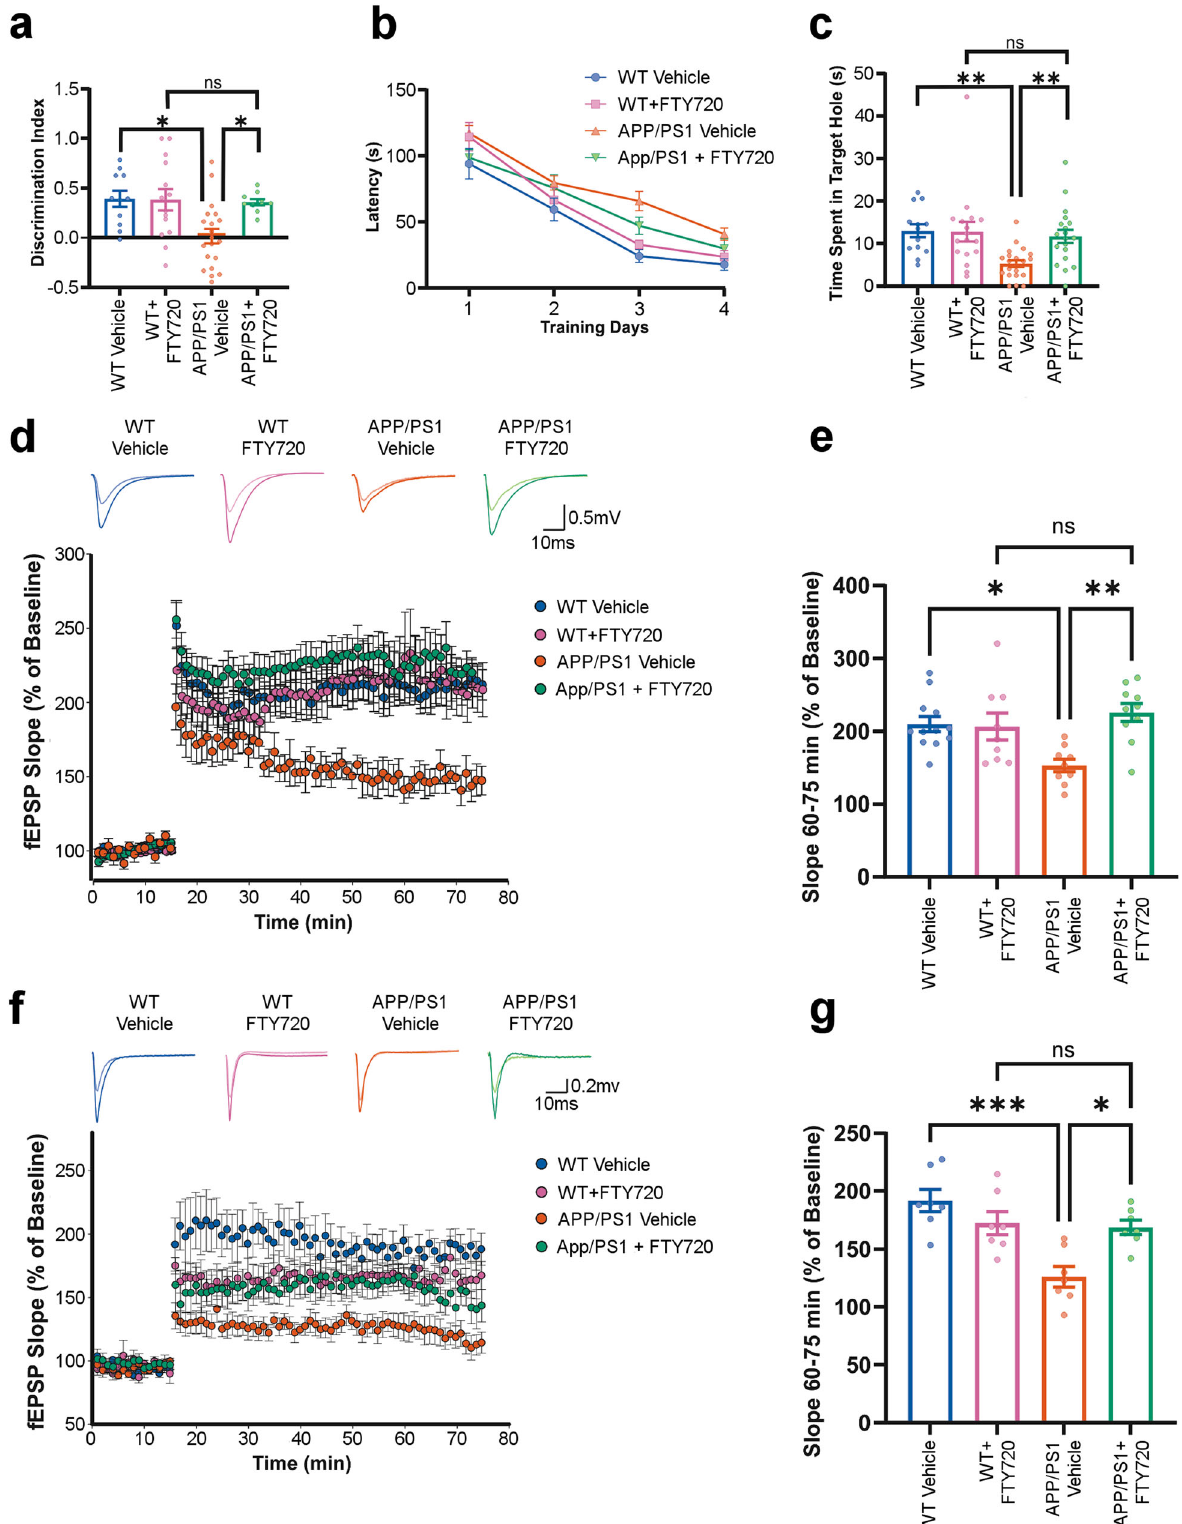
genes encoding the core enzymes in the pathway are signi fi cantly differentially expressed in the AD population. The only sub- pathway that appears to be unaffected by or uninvolved in the disease is the synthesis and recycling of glycosphingolipids.